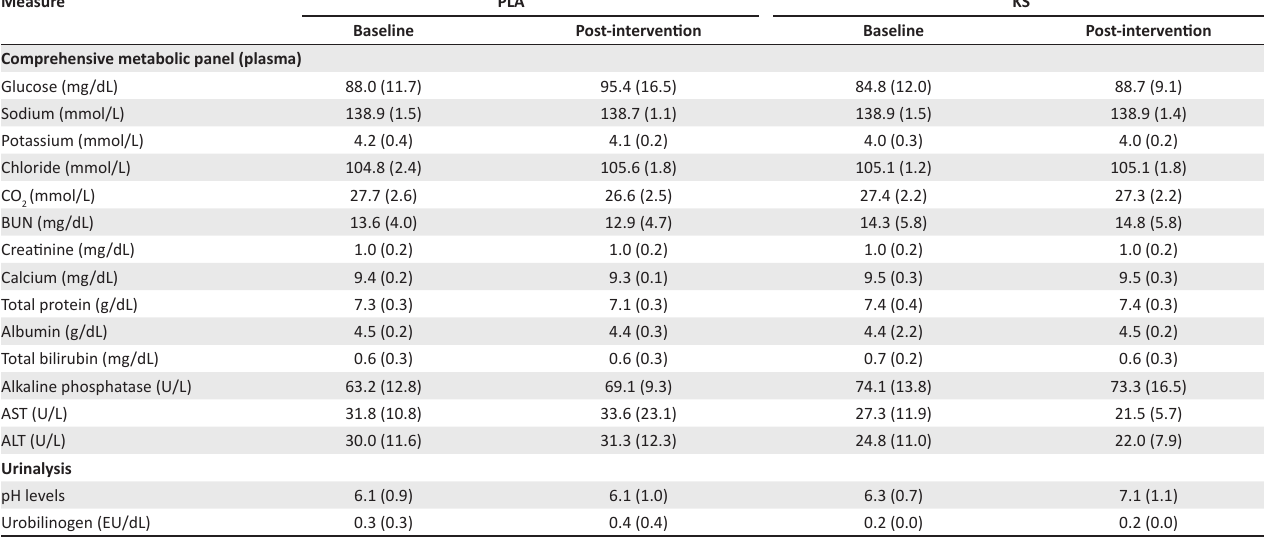
TABLE 2: Comprehensive metabolic panel and urinalysis before and after taking the placebo or ketone salt supplement for 6 weeks. Measure PLA KS Baseline Post-intervention